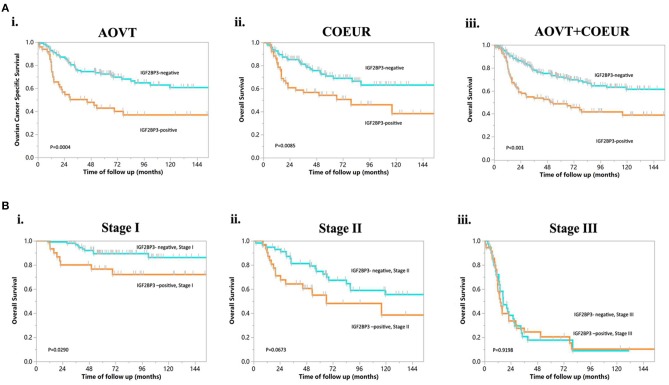
Kaplan-Meier curves of overall survival in OCCC. (A) IGF2BP3 expression in patients from different cohorts. (i) OCCC from AOVT, (ii) OCCC from COEUR, (iii) OCCC from both AOVT and COEUR. (B) IGF2BP3 expression in patients with different FIGO stages: (i) stage I, (ii) stage II, (iii) stage III.